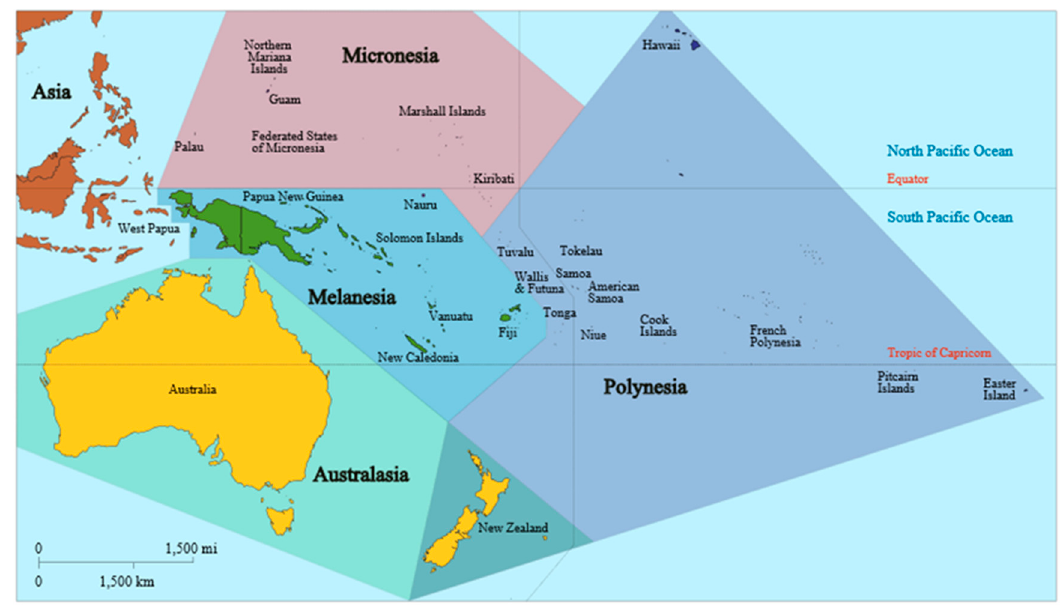
Figure 1. Map of Oceania based on the United Nations geoscheme M49 coding classification, devised by the United Nations Statistics Division.